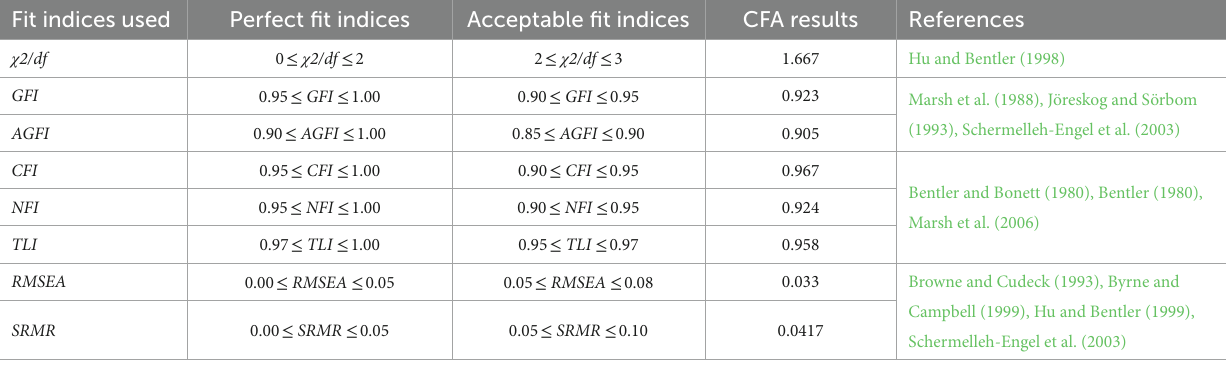
TABLE 2 CFA fit indices for the whole BOSSm18 model. Fit indices